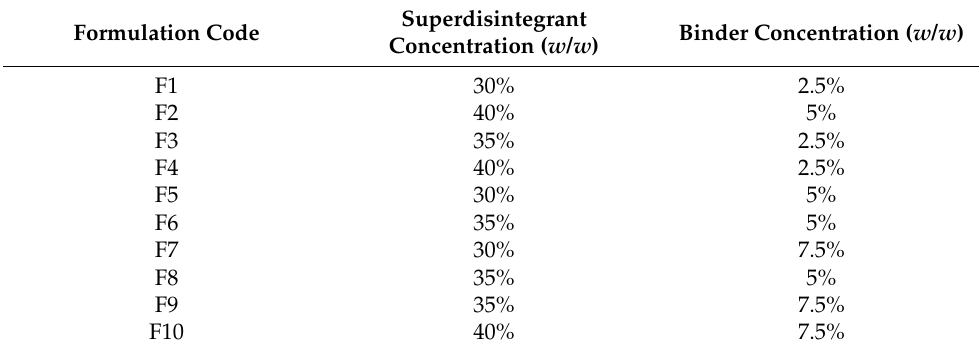
Table 2. Matrix of CCD for CBZ ODMT formulations.